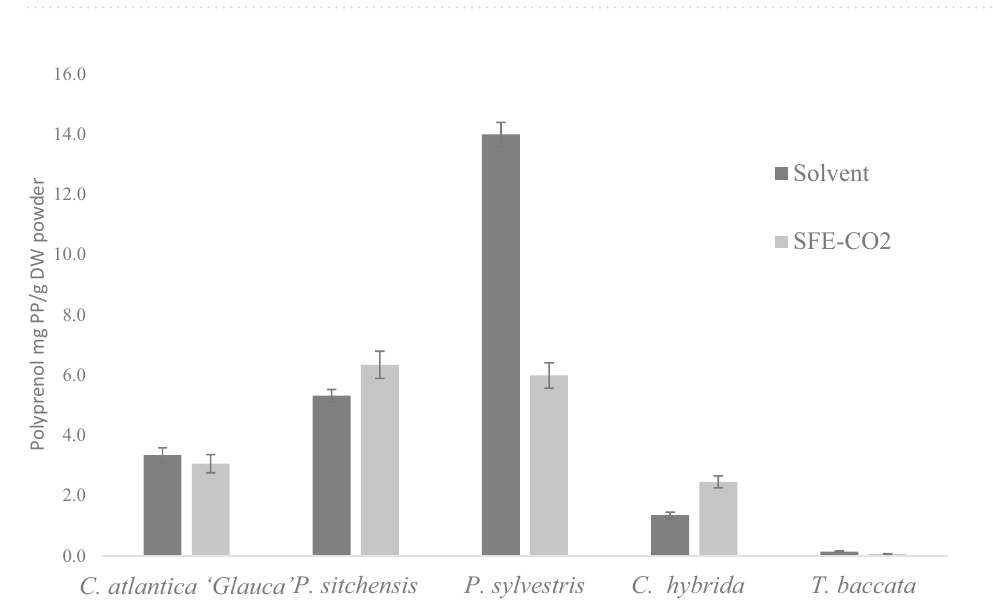
Table 4. Polyprenol chain length identified from HPLC chromatogram in P. sitchensis, P. sylvestris, C. hybrida and T. baccata . The plant needles/leaves were extracted with hexane:acetone (1:1 v/v) and SFE-CO 2 treatment 8 ◦ C (200 bar, 70 , 7 h and 100% ethanol as a modifier).